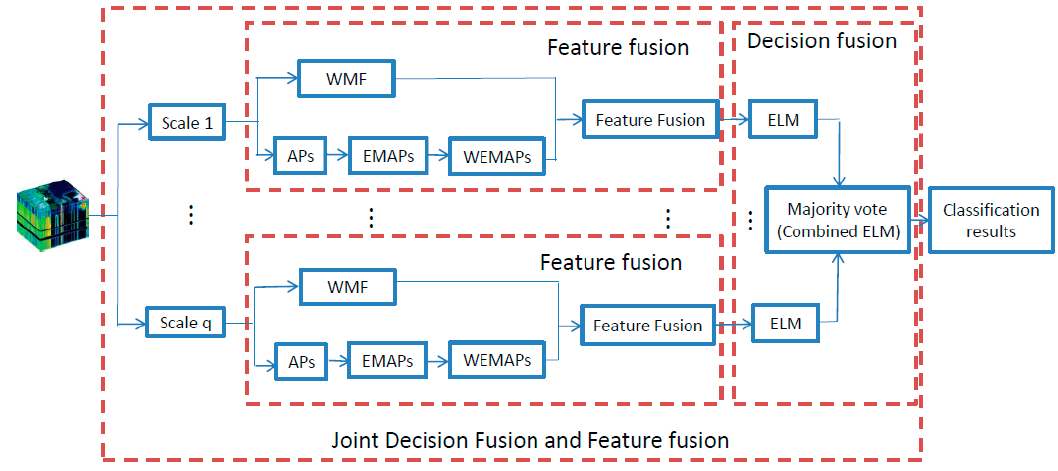
Figure 1. The flowchart of the proposed JDFFF framework for HSI classification.